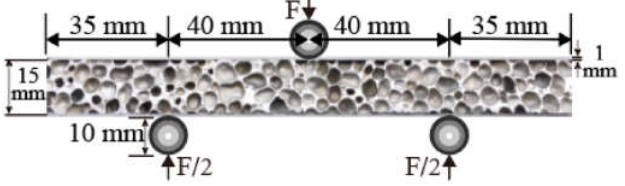
Figure 5. Schematic diagram of three-point bending test.